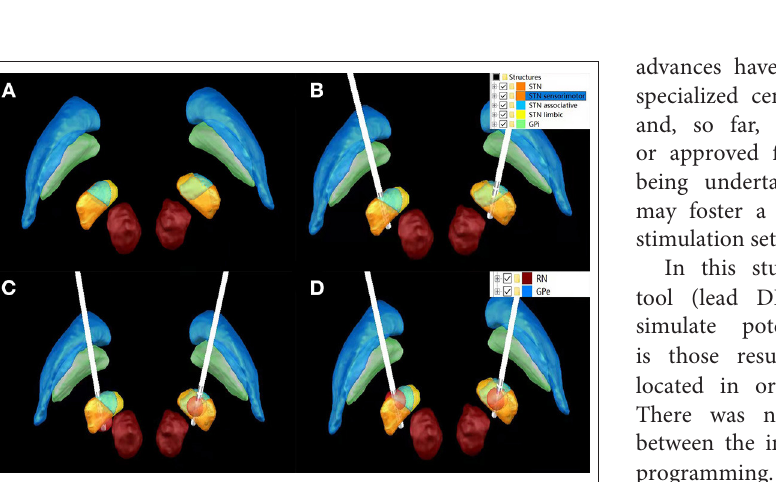
FIGURE 2 | Bilateral STN morphology without Lead implantation (A) ; Lead implantation on bilateral STN (B) ; 1.5V stimulation of K1 contact of left Lead involved sensorimotor, associative and limbic regions, while 1.5V stimulation of K8 contact of left Lead only stimulated sensorimotor regions (C) ; 1.5V stimulation of K1 contact of lead on the left and K10 contact of lead on the right involved sensorimotor, Associative and limbic functional areas (D)